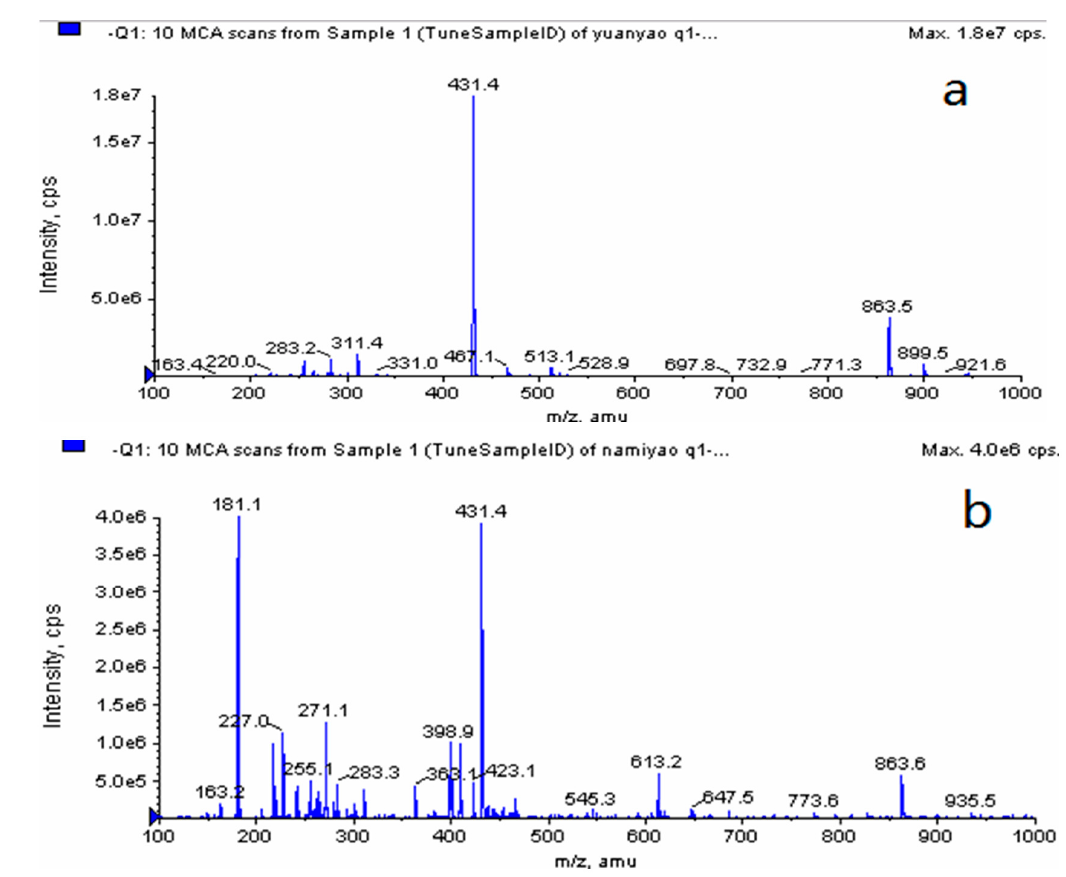
Figure 6. LC-MS spectra of ( a ) raw vitexin and ( b ) vitexin nanoparticles.